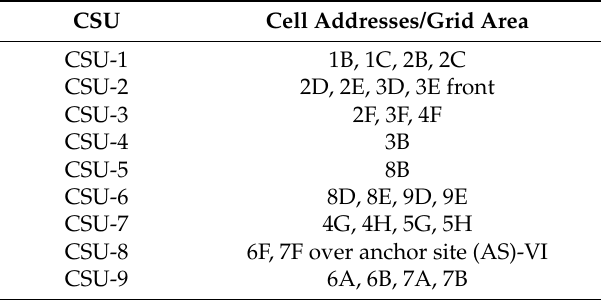
Table 2. Spatial definition of complementing structural units (CSU) on